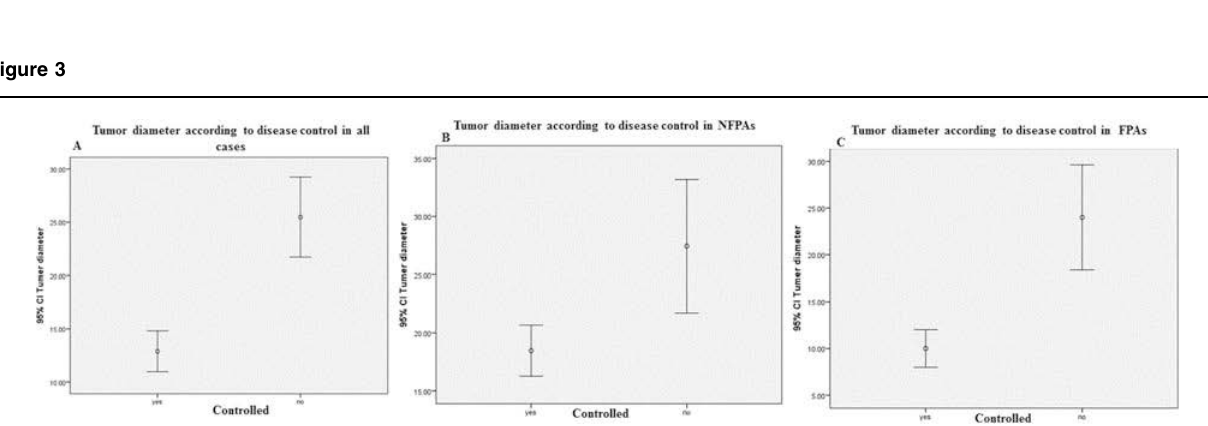
Sagittal T 1 -enhanced MRIs of two cases with pituitary macroadenomas. (a), (b) Preoperative suprasellar extension (grades B and D, respectively). (c) Postoperative gross total resection with no residual tumour. (d) Postoperative partial resection with initial descent of the suprasellar residual into the sellar plane.